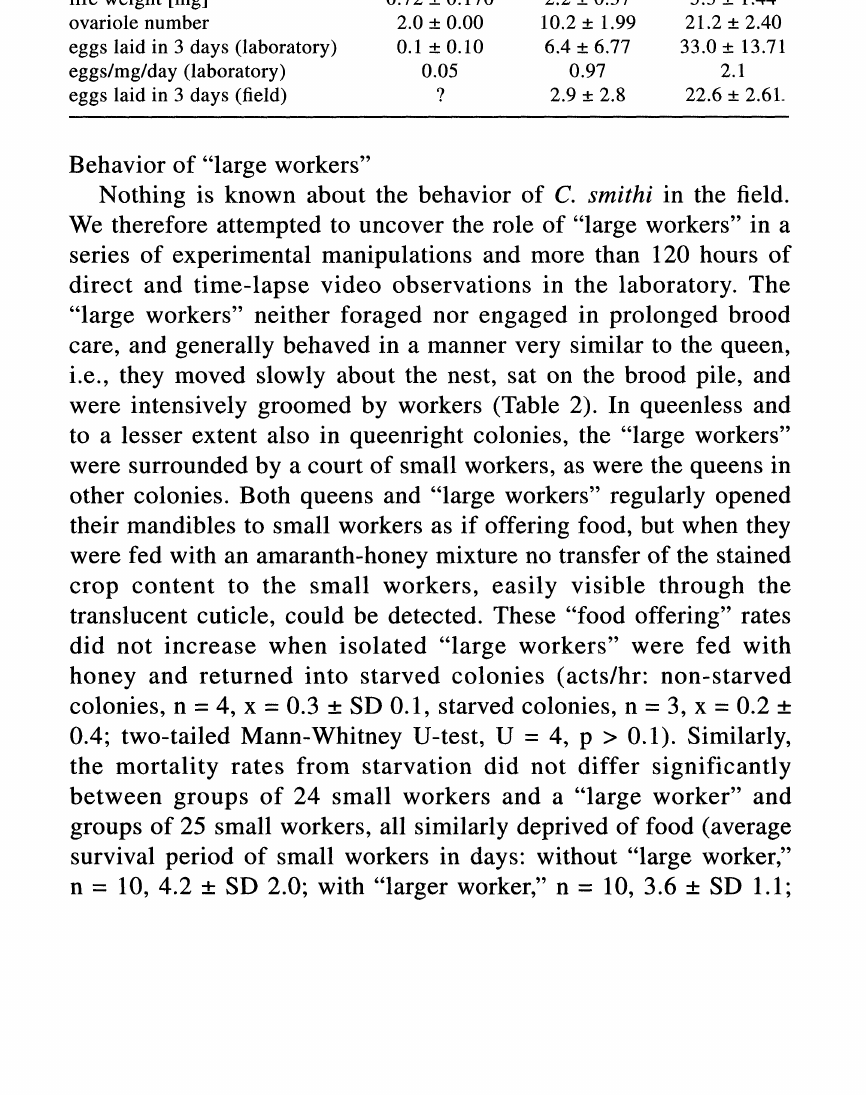
Table 1. Size, weight, ovariole number, and fecundity of the three female castes in the ant, Crematogaster smithi. The various parameters could not be examined in all specimens. The number of individuals examined ranged between 10 and 100 (workers), 8 and 12 ("large workers"), and 3 and 10 (queens). Egg laying data are from colonies which were transferred from the field into the laboratory on the first day of the experiment ("field") or from colonies which had been kept in the laboratory for at least two months